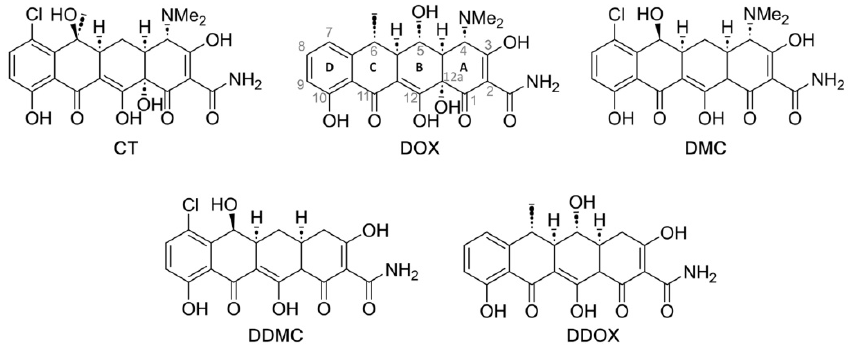
Figure 3. TCs tested in this study. Conventional numbering of the condensed rings and key positions are shown for DOX . The four rings of the TC core structure are designated by A,B,C,D.